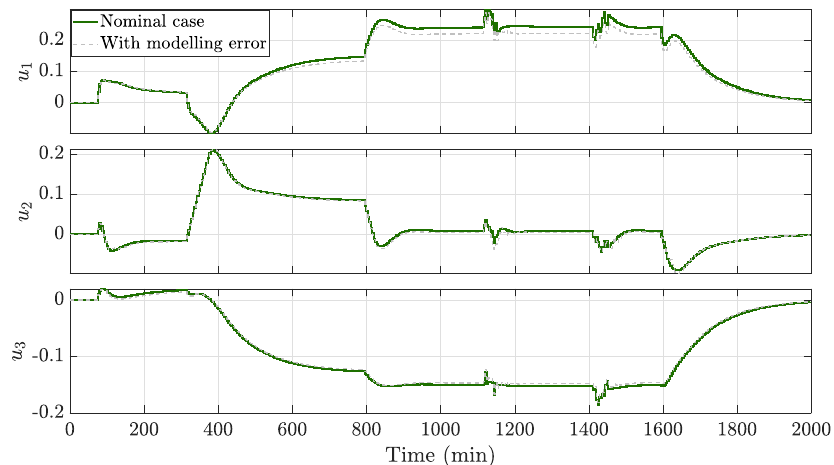
Figure 12. Case 2—Manipulated variables of the